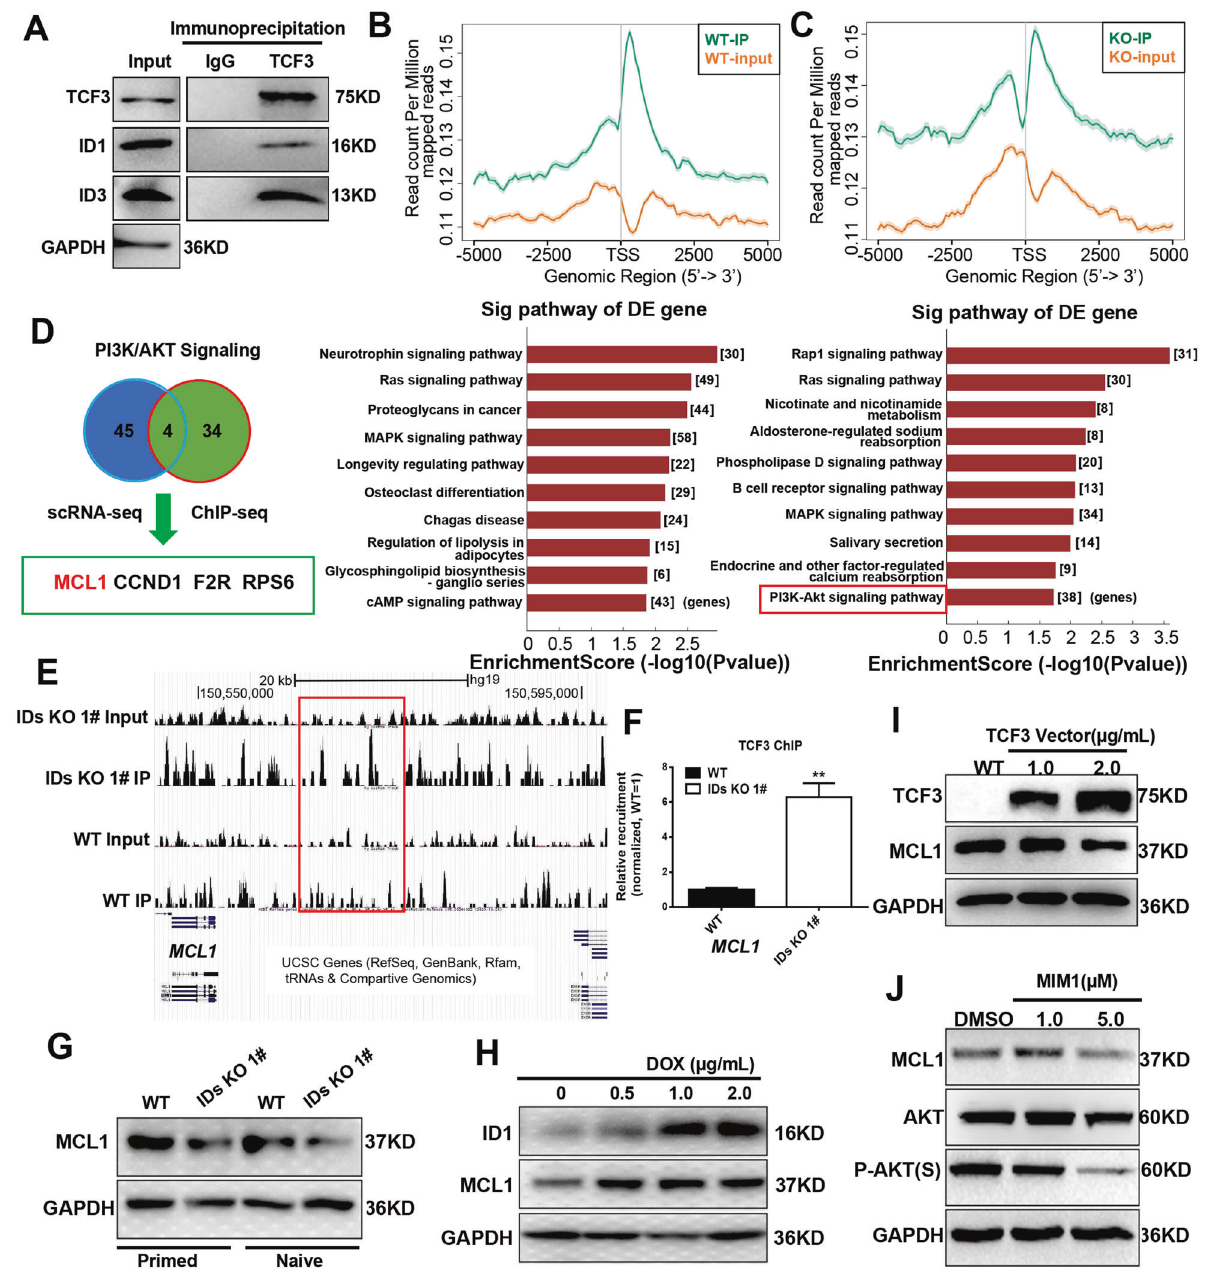
Fig. 6 Identify MCL1 as a target of the ID-E protein axis in the regulation of AKT phosphorylation. A TCF3 was immunoprecipitated from WT hESCs; then, the amount of ID1 and ID3 present in the precipitate was evaluated via Western blots. B Peak annotation plot of TCF3 ChIP- seq analysis in WT and KEGG analysis of the genes that TCF3 binding at in WT. C Peak annotation plot of TCF3 ChIP-seq analysis in the IDs KO cells and KEGG analysis of the genes that TCF3 binding at in IDs KO. D Screening strategy for identifying potential genes that mediate AKT phosphorylation through TCF3. E , F TCF3 signal track for the representative locus MCL1 in WT and IDs KO hESCs from ChIP-seq data, and the binding of promoter sequences for MCL1 to TCF3 was evaluated in WT and IDs KO hESCs via ChIP-qPCR ( n = 3). ** p < 0.01 compared with WT; t -test. G Western blot detect the protein level of MCL1 in both primed and naive-like hESCs. H Western blot detect the ID1 and MCL1 expression level in ID1 overexpressed line. I Western blot analysis the TCF3 and MCL1 protein level when TCF3 vector was transfect to 293 cell 48 h. J Western blot analysis the MCL1, AKT, P-AKT protein level in the cell that treated with different concentrate of MCL1 inhibitor MIM1 48